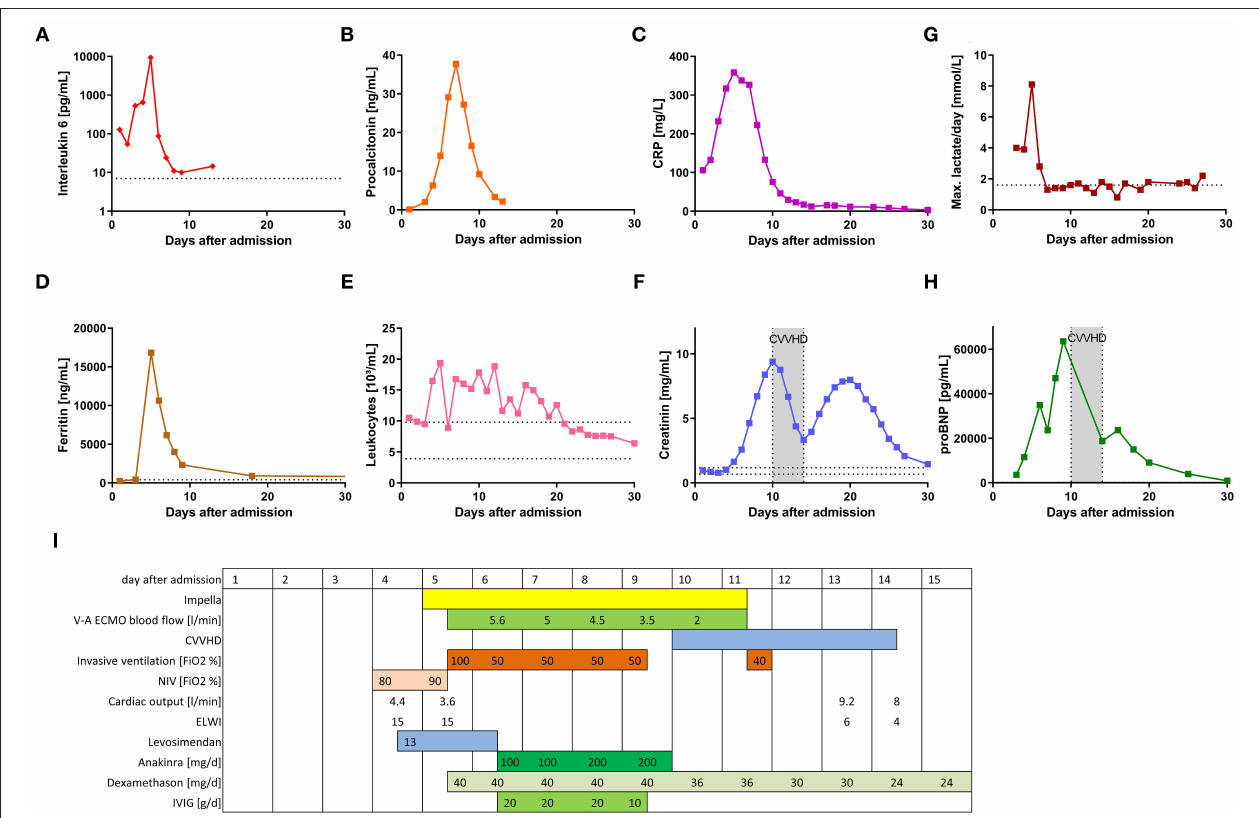
FIGURE 1 | Clinical and treatment parameters of the patient during the 1st month after hospital admission. (A–H) show the time course of different laboratory parameters during the first 30 days following hospital admission. (I) displays a timeline of the different clinical parameters and specific therapy during the first 30 days.